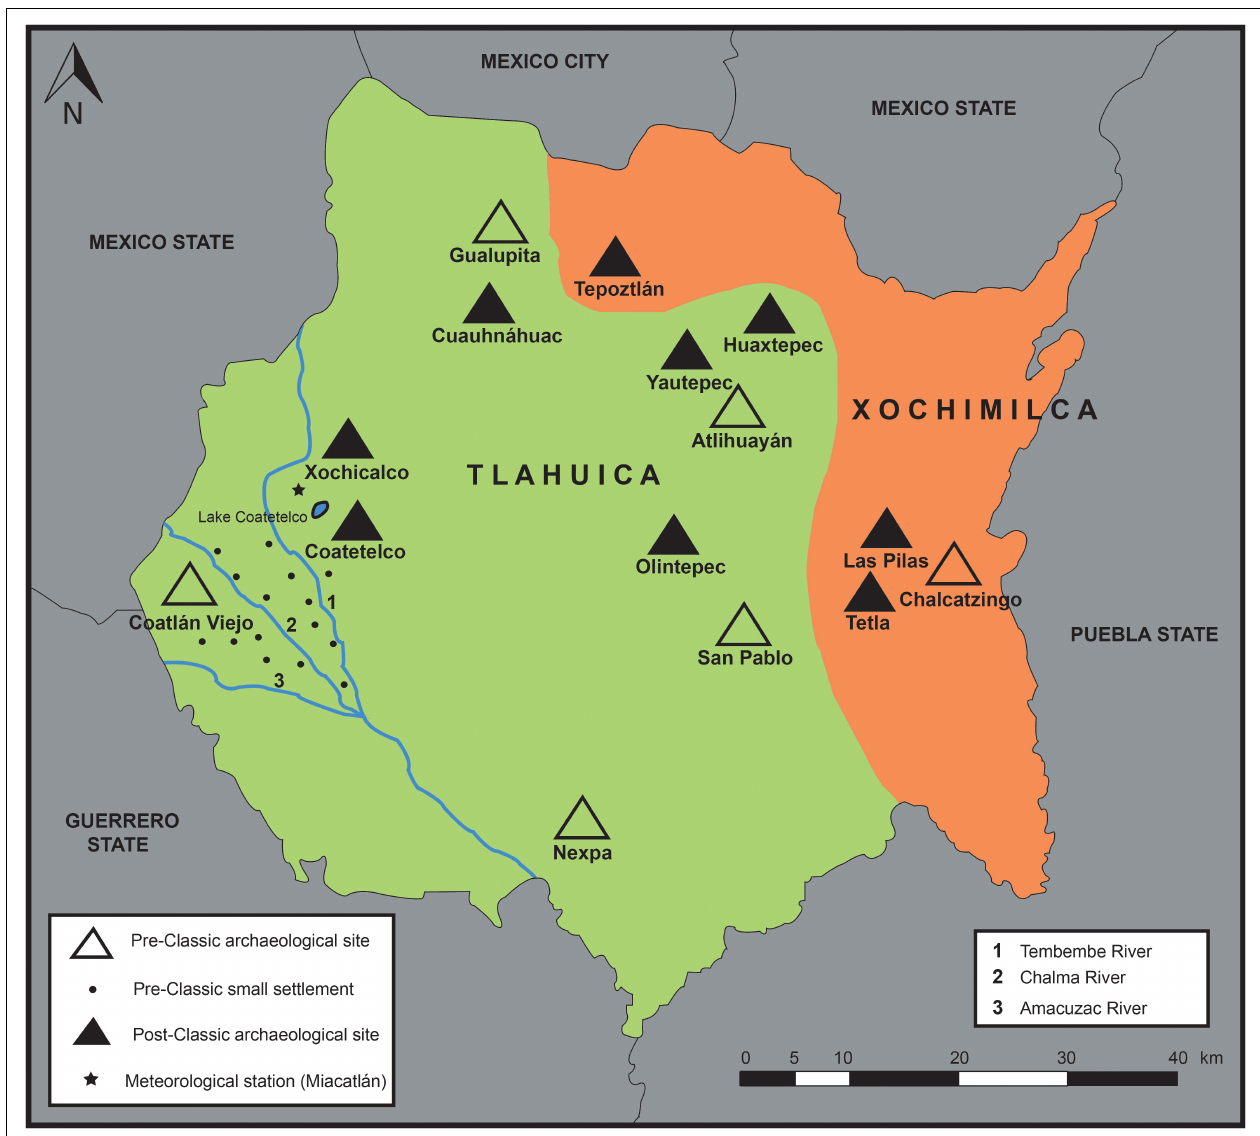
FIGURE 2 | Map showing the locations of settlements since the Pre-Classic period of Mesoamerica in vicinity of the Lake Coatetelco and banks of important rivers in the region. Coatetelco had small settlements since ∼ 500 BCE and it remained as an important regional center until its conquest by the Mexica during ∼ 1430 CE. Xochicalco was a confederation of towns during the late Classic period (650–900